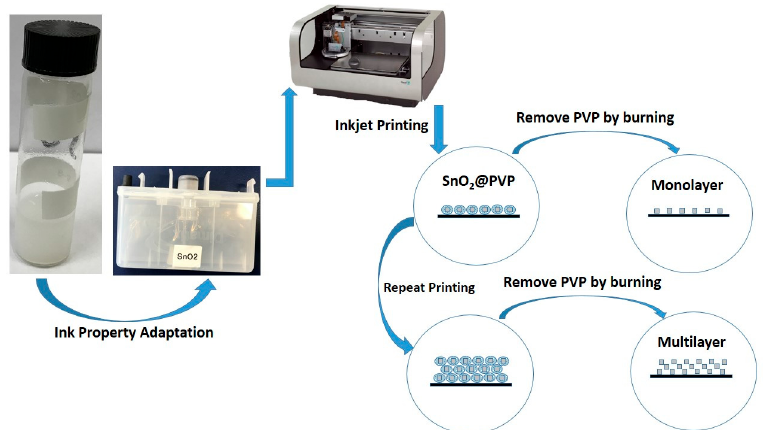
Figure 1. Schematic overview of the layer-by-layer production process. Using colloidal inks with low solid state content it is possible to tune the deposited layer thickness from below a monolayer to a porous multilayer system via repetitive dropping of ink dot on the same spot.